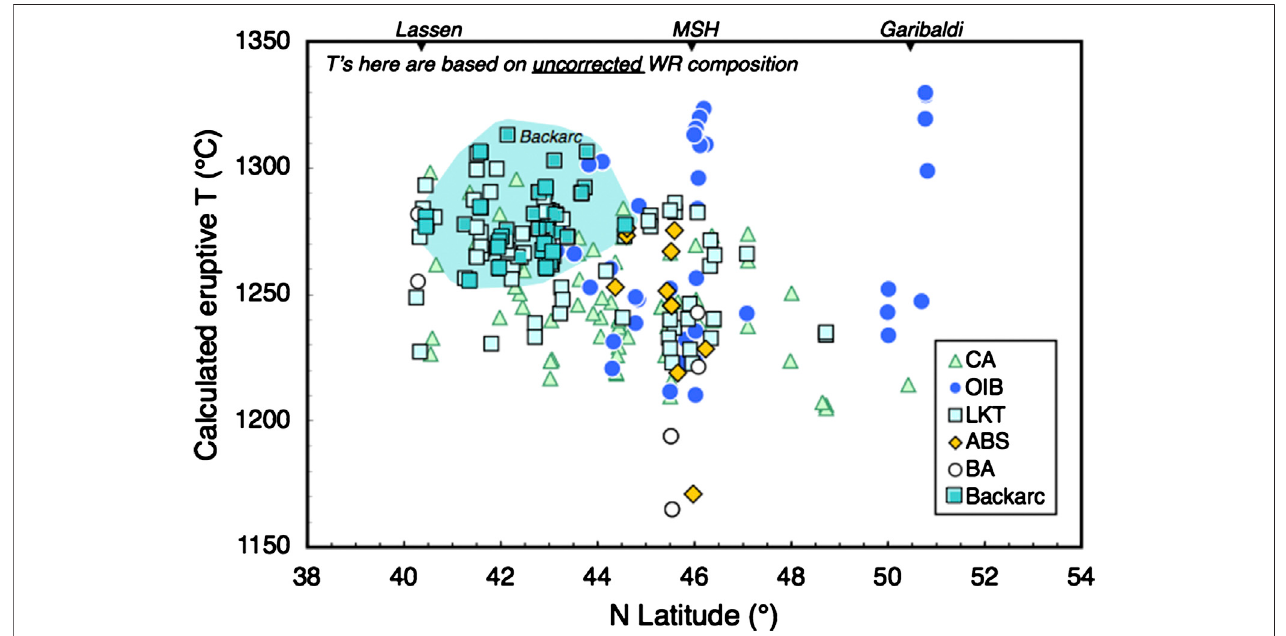
FIGURE 13 | Estimated eruptive temperatures for samples of primitive magma types along strike in the Cascade arc (cf. Leeman et al., 2005). Data for far backarc LKTs from the High Lava Plains in eastern Oregon (cf. Till et al., 2013) are superimposed for comparison (outlined in green fi eld). Temperatures are calculated for lavas with MgO > 7 wt% (see Supp lementary Material for details). Thermometry is most robust for the LKTs owing to their low water contents. Of signi fi cance is the general increase in magmatic temperatures for Cascades LKT going southward from southern Washington (Mt. St. Helens area) to northern California (Lassen area).